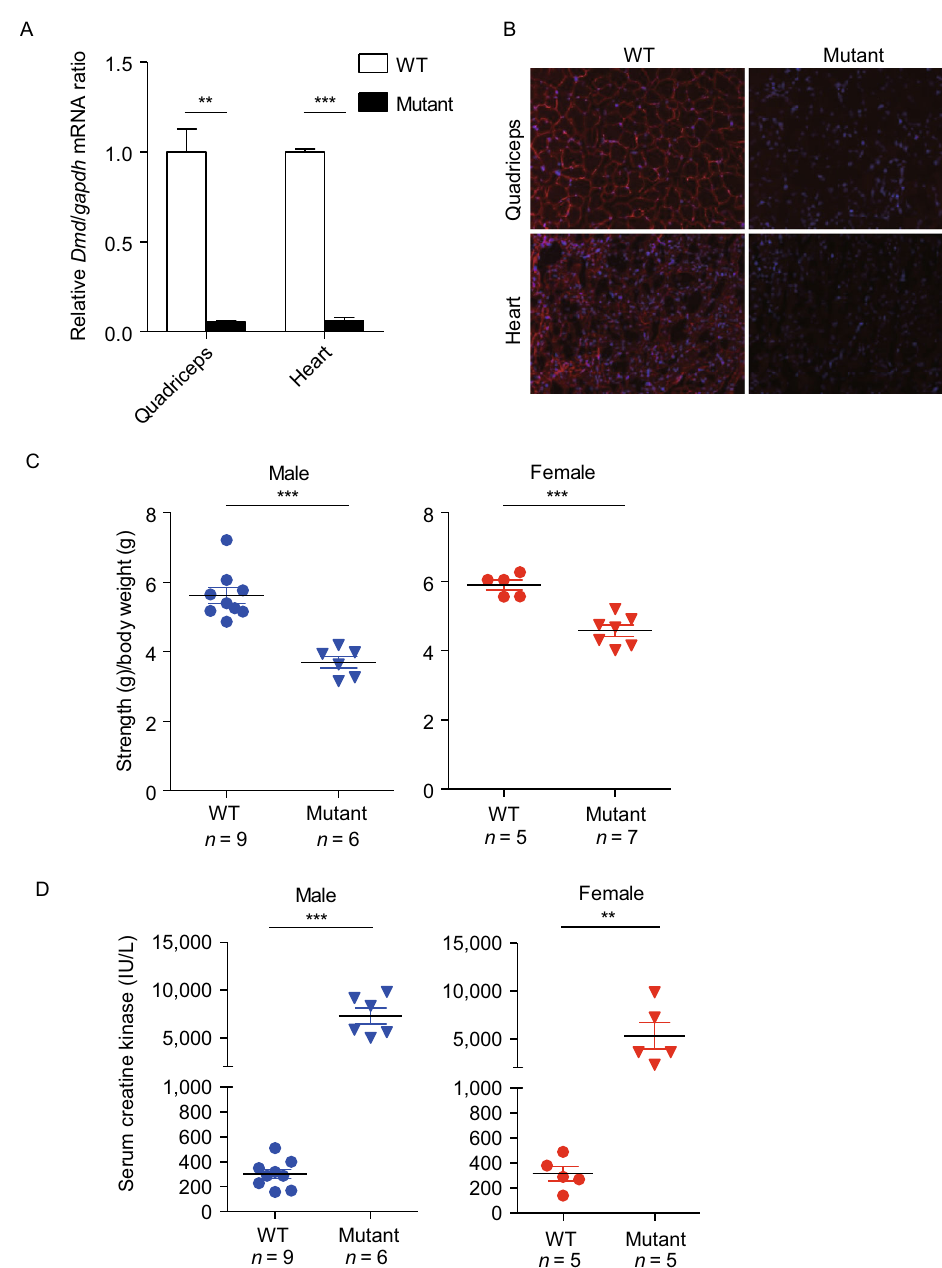
Figure 2. One-step generation of DMD mice by ABE-induced mRNA splicing defect strategy (AI-MAST) . (A) qPCR was carried out using RNAs extracted from the quadriceps and hearts of WT (D1 – 4, D1 – 14, D1 – 31) and mutant mice (D1 – 18, D1 – 25, D1 – 27) to quantify correctly spliced Dmd mRNAs. Data are presented as mean ± SEM ( n = 3). ** P < 0.01. *** P <0.001. Statistical signi fi cance was determined using the two-tailed Student ’ s t -test. (B) Immuno fl uorescence staining of Dmd in WT and mutant mice from (A). Representative images from pups D1 – 4 (WT) and D1 – 18 (mutant) were shown ( n = 3). (C) Forelimb grip strength of 4 – 5 week old male and female mice from the Dmd gRNA-1 group was assessed using a force transducer. *** P < 0.001. Statistical signi fi cance was determined using the two-tailed t -test. (D) Serum creatine kinase levels in 4 – 5 week old male and female mice from the Dmd gRNA-1 group were determined. ** P < 0.01, and *** P < 0.001. Statistical signi fi cance was determined using the two-tailed t -test. (E and F) Analysis of human disease splice site mutations that may be modeled by ABE7.10 (E) and xCas9(3.7)-ABE7.10